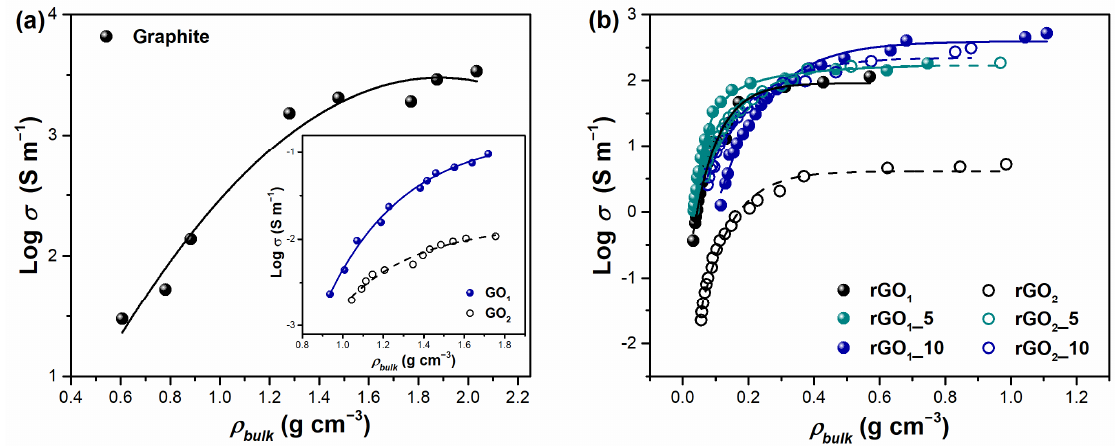
Figure 6. Electrical conductivity dependence on bulk density for graphite ( a ) and thermally reduced GO samples ( b ). The inset in ( a ) demonstrates the relationship between electrical conductivity and bulk density for GO 1 and GO 2 samples.